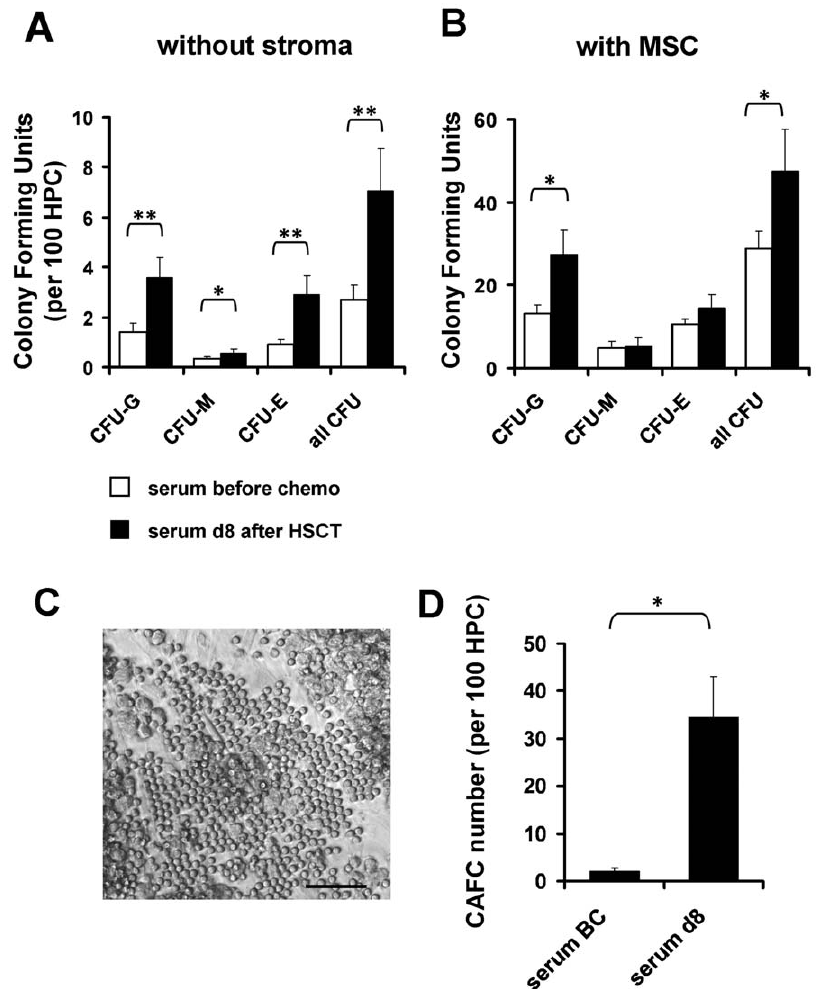
Figure 3. Colony forming unit frequency is enhanced by serum of aplastic patients. CD34 + HPC were cultured either without stroma (A) or in co-culture with MSC (B) in culture medium supplemented with serum taken before chemotherapy or day 8 after HSCT. After seven days of in vitro expansion, cells were re-seeded in methylcellulose medium and after two weeks numbers of granulocyte (CFU-G), macrophage (CFU-M) and erythrocyte colonies (CFU-E) were counted. Overall, colony formation was enhanced upon expansion with d8 serum. CFU-frequency was greatly increased by co-culture with MSC, and this was further stimulated by serum from d8. Furthermore, cobblestone area forming cell (CAFC) frequency was determined after 4 weeks of co-culture with MSC (C). The CAFC frequency was greatly enhanced by addition of d8 serum (D) (n=4; * =p , 0.05; ** =p , 0.01; error bars represent SEM; size bar =100 m m).